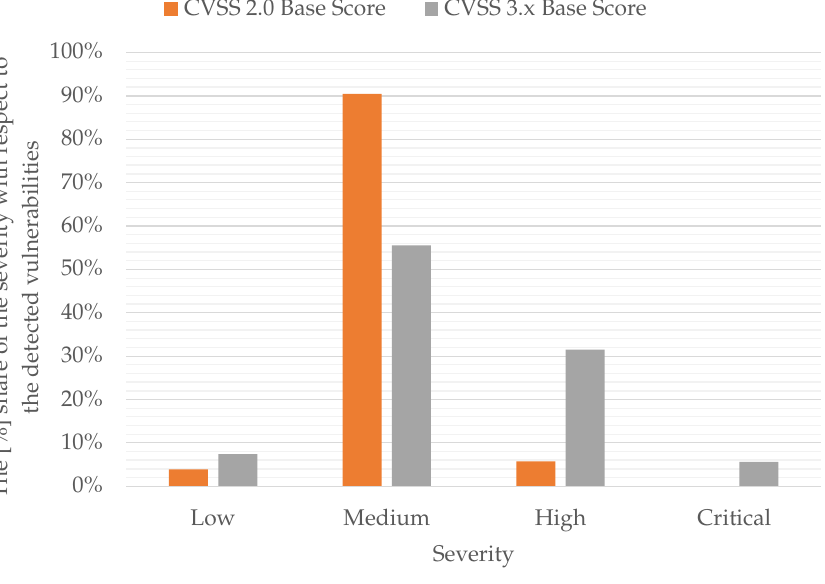
Figure 5. Vulnerability severity histogram divided into the base CVSS 2.0 and 3.x scores for environ- ment